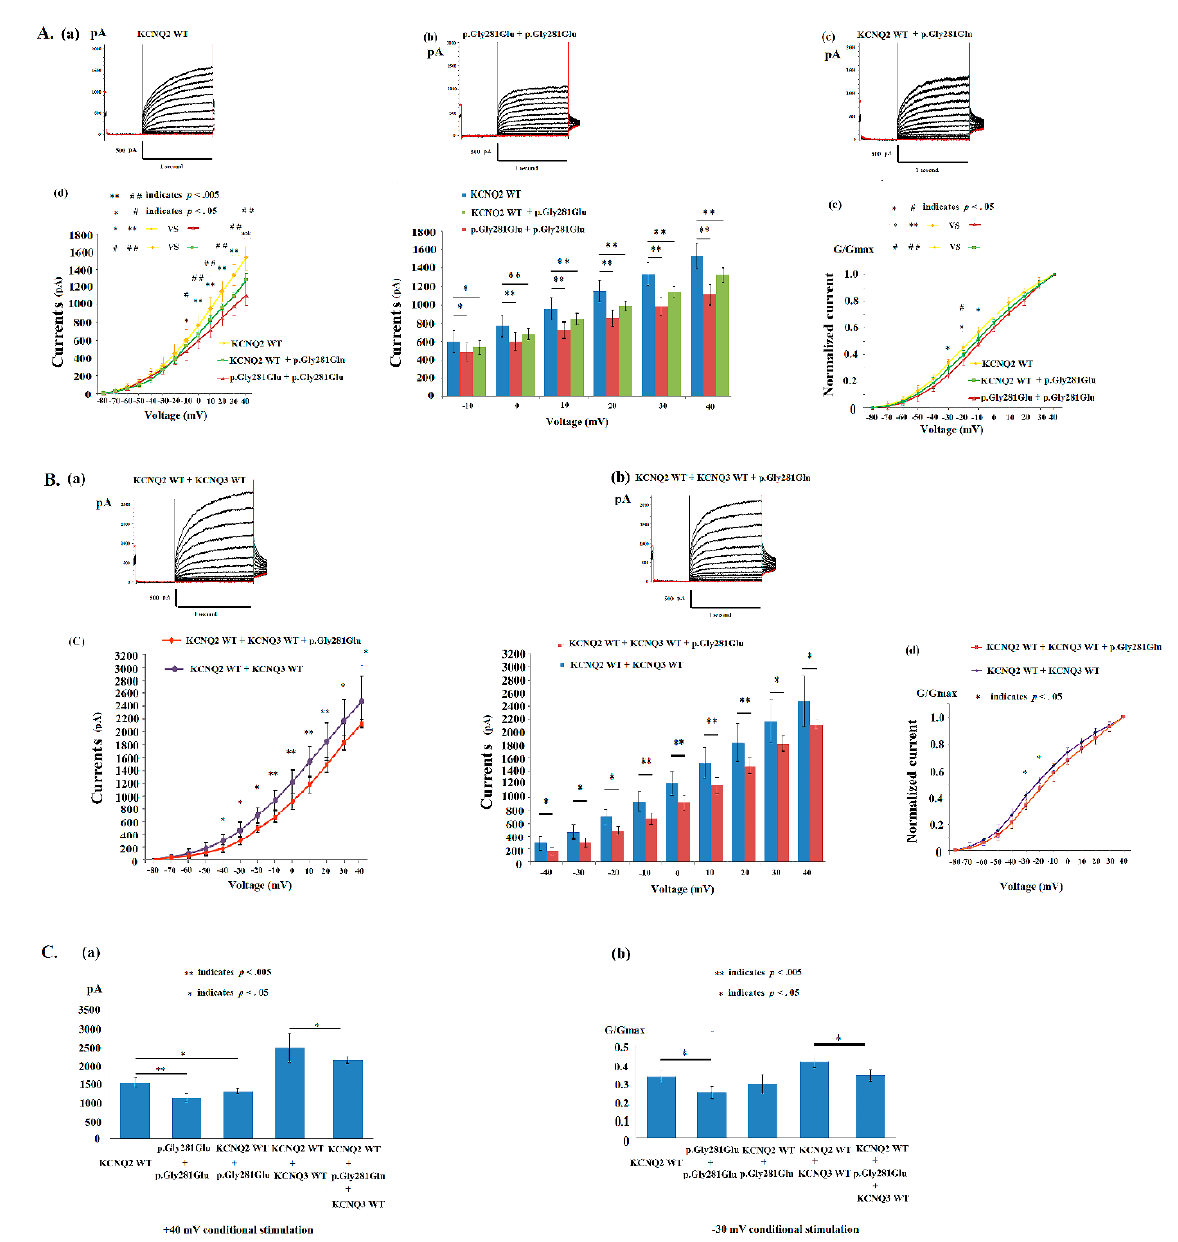
mutations in homomeric currents were lower in V 1/2, the K slope and currents (Table 2). After the transfection with the heteromeric KCNQ2 WT and variants and with the KCNQ3 WT (0.5 µ g:0.5 µ g:1 µ g), the current amplitudes remained lower in the mutations (Table 2 and Supplementary Table S1).